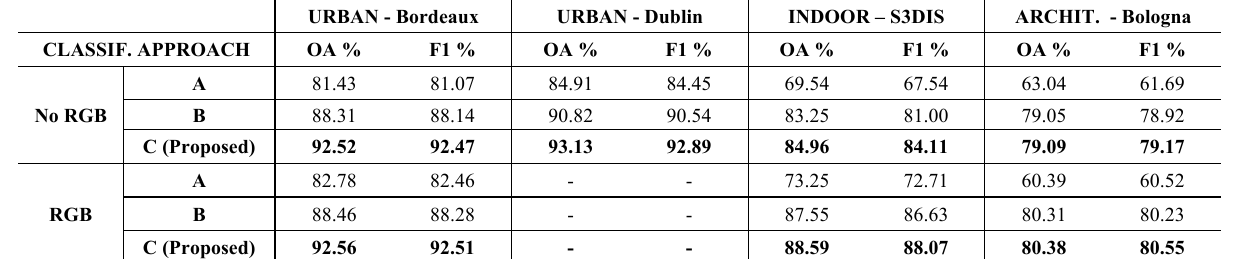
Table 2. Classification metrics achieved in the four scenarios using different features.